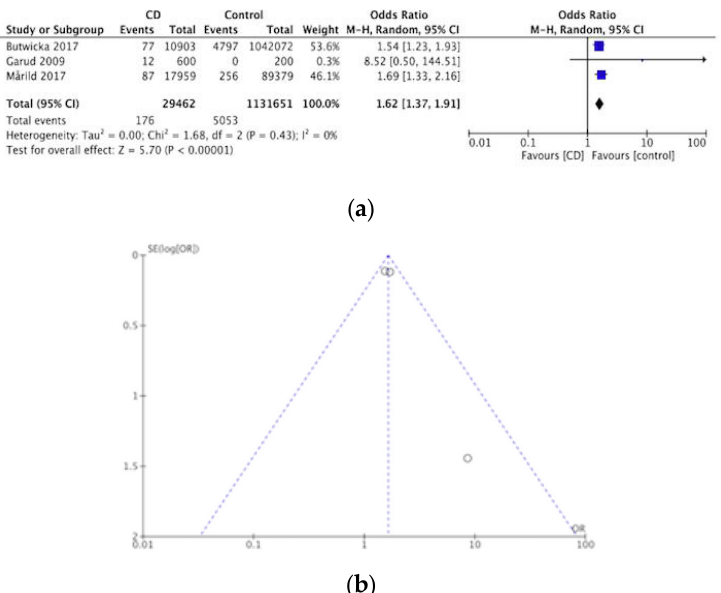
Figure 8. ( a ) Forest plot of pooled prevalence of eating disorders in CD. ( b ) Funnel plot investigating distribution in eating disorder studies. distribution in eating disorder